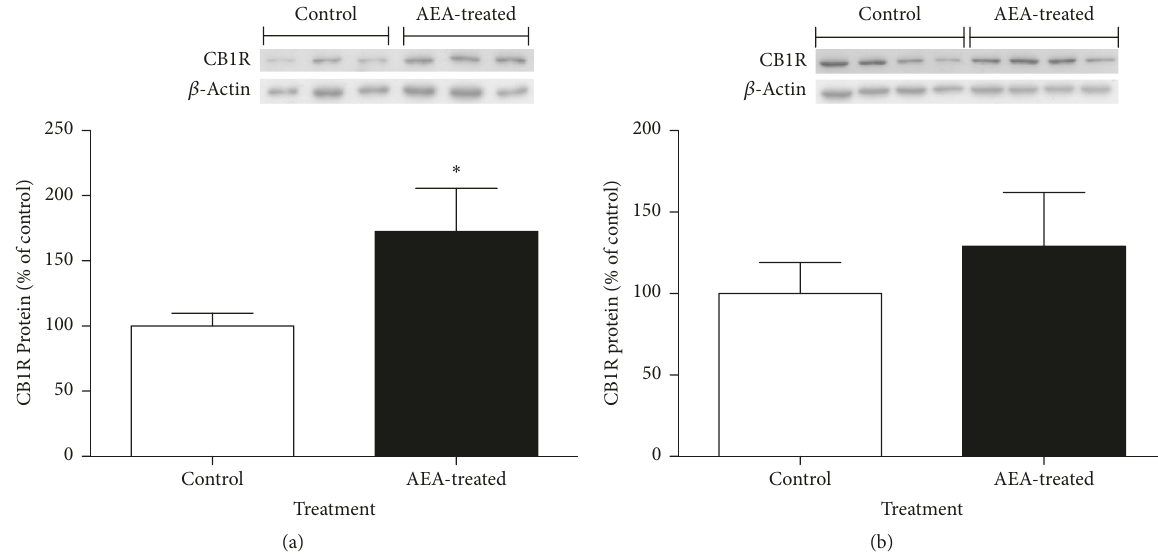
Figure 2: Relative levels of CB1R protein in hypothalamus of (a) 21-day-old and (b) adult AEA-treated and control mice. For densitometry quantification purposes, B-actin was used as loading control. Results are expressed as a percentage relative to the expression in control mice. ( ∗ 𝑃 < 0.05/ ∗∗ 𝑃 < 0.01 Mann–Whitney 𝑈 test; mean ± SEM; 𝑛 = 6 /group).